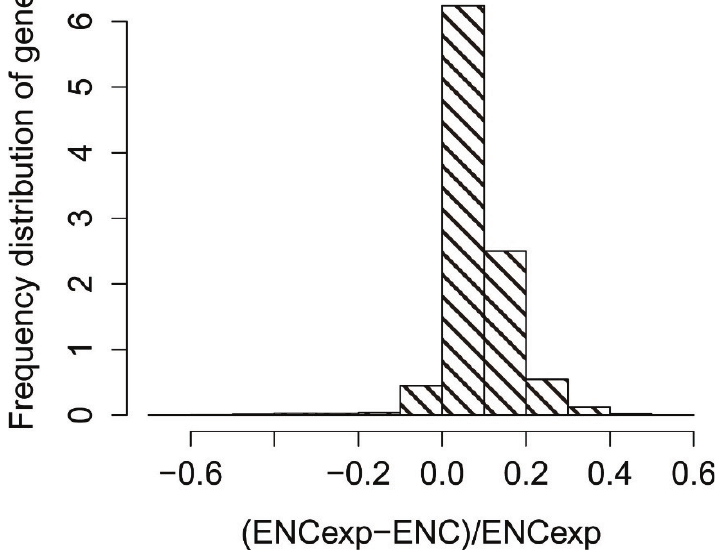
Figure 4. Frequency distribution of the effective number of codons (ENC)